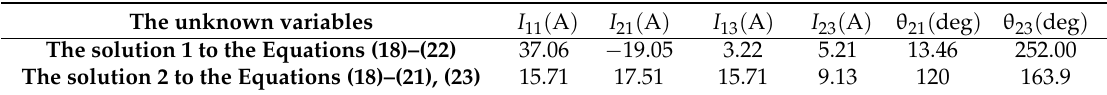
Table 3. The optimum solutions to the fault-tolerant current under adjacent double-phase open-circuit fault